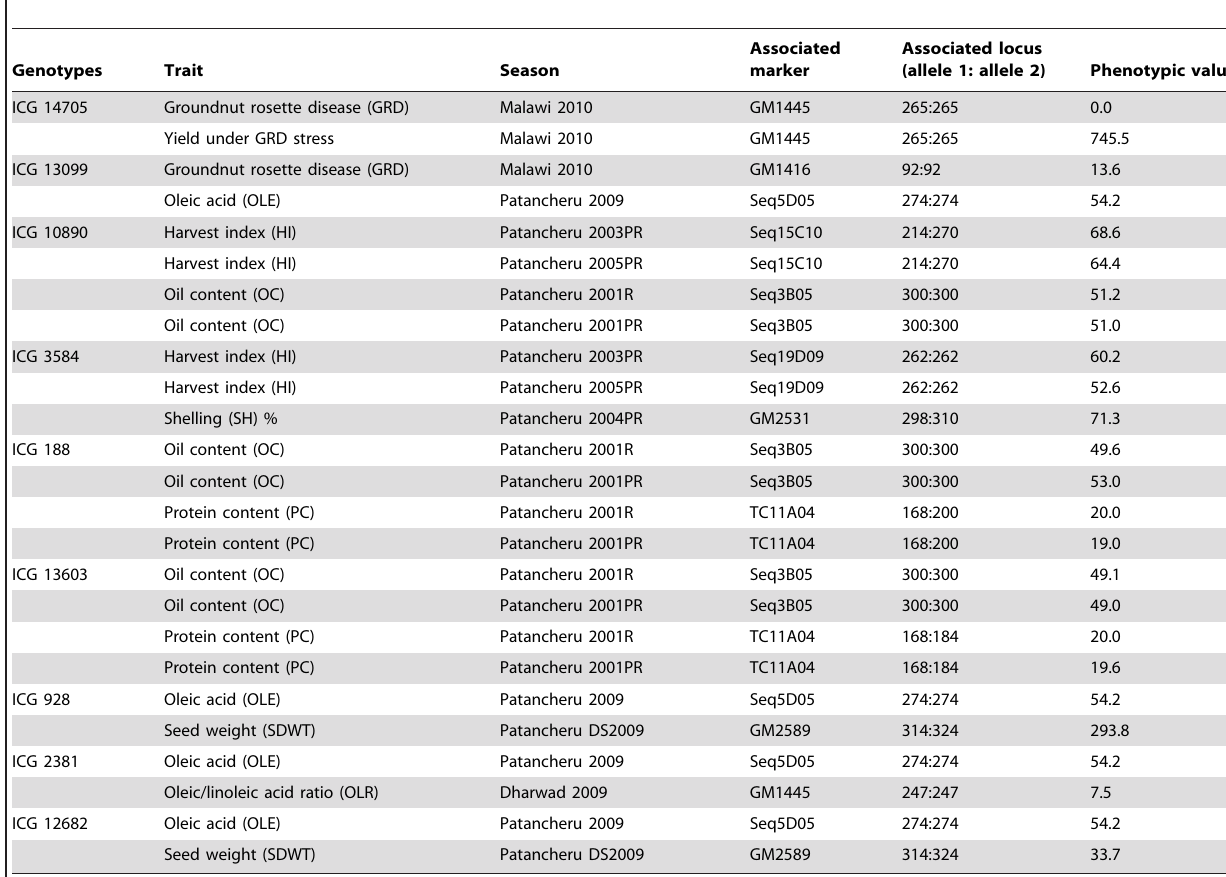
Table 3. Selected genotypes possessing desirable allelic combination for multiple traits.